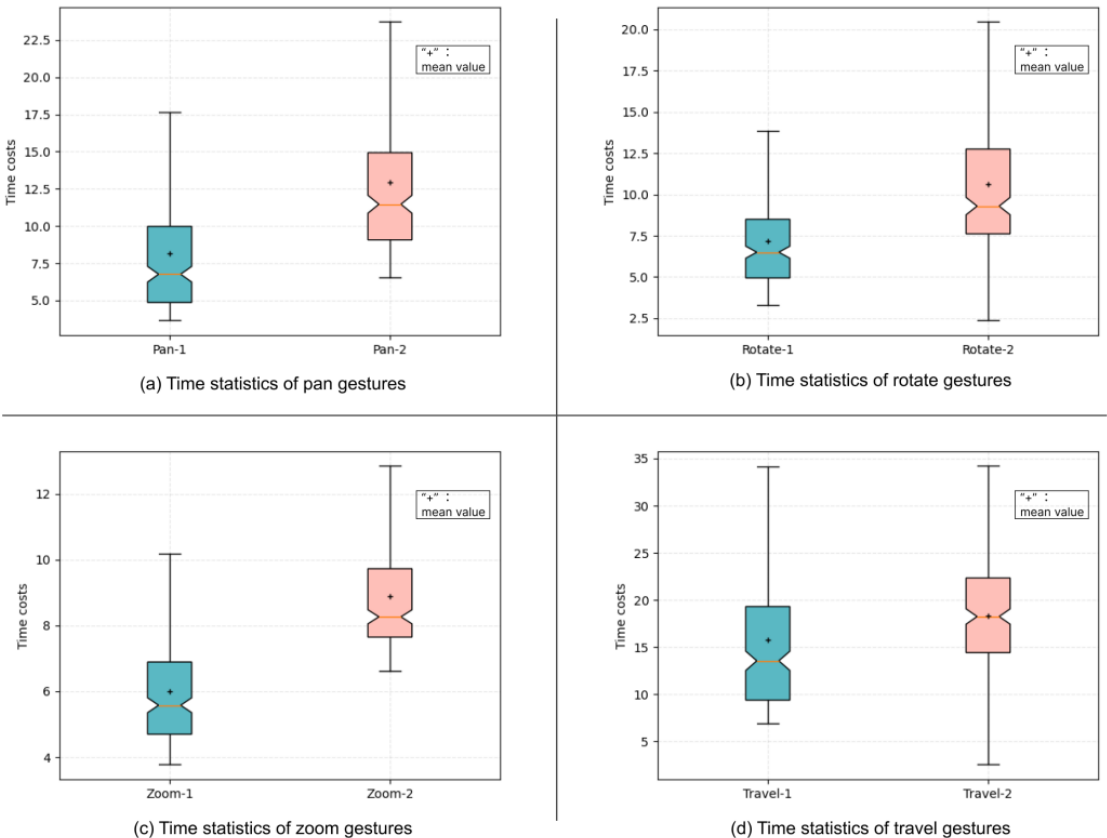
Figure 7. Results of the time costs comparison experiment.